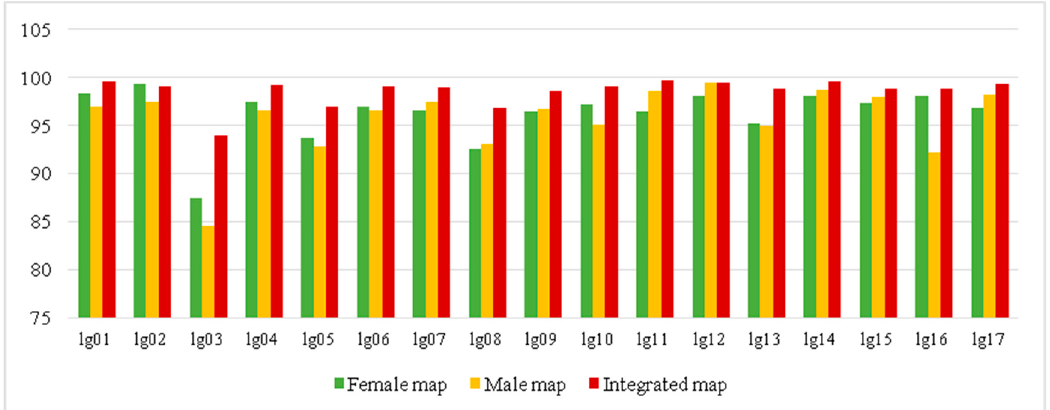
Figure 3. The percentage of gap numbers with genetic distance less than 5 cM (gap < 5 cM) between markers in female, male, and integrated maps. The abscissa represents linkage group and the vertical axis represents gap < 5 cM number. Table 1. Characteristics of the integrated genetic map derived from the F 1 population (‘Huazhong 8’ and ‘Huazhong 12’).